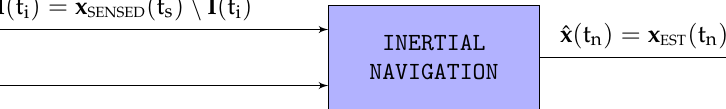
Figure 5. INS flow diagram.